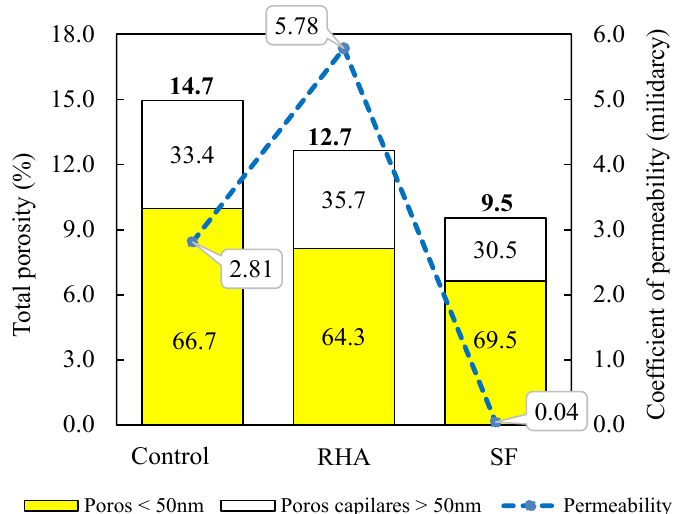
Figure 9. Porosity e permeability of